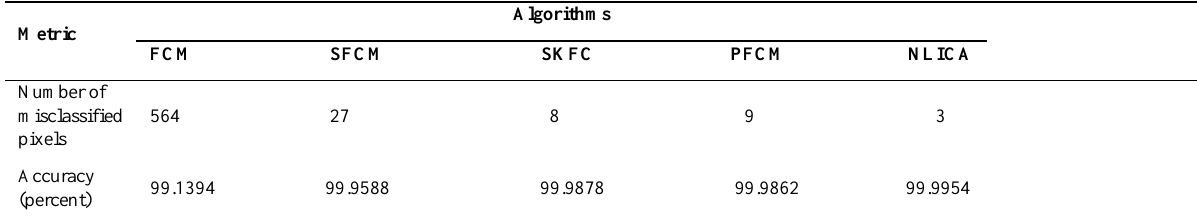
Table 2. Segmentation results of image number